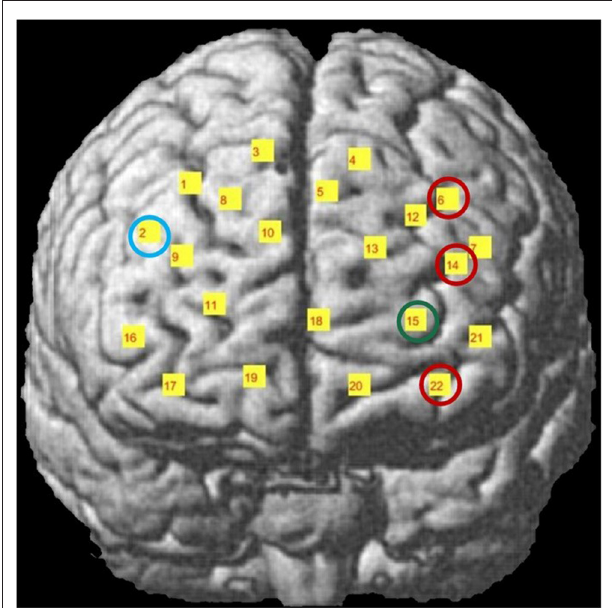
FIGURE 5 | Channel locations of fNIRS probe mapped onto a standard brain template in MNI space. Channels with significant hemodynamic activation are illustrated with colored circles. (Red circle: Human Face > Robot Face, Green circle: Robot Voice < Human Voice, Blue circle: Human Face Robot Voice > Robot Face Robot Voice). Adapted from Mutlu et al. (2020).